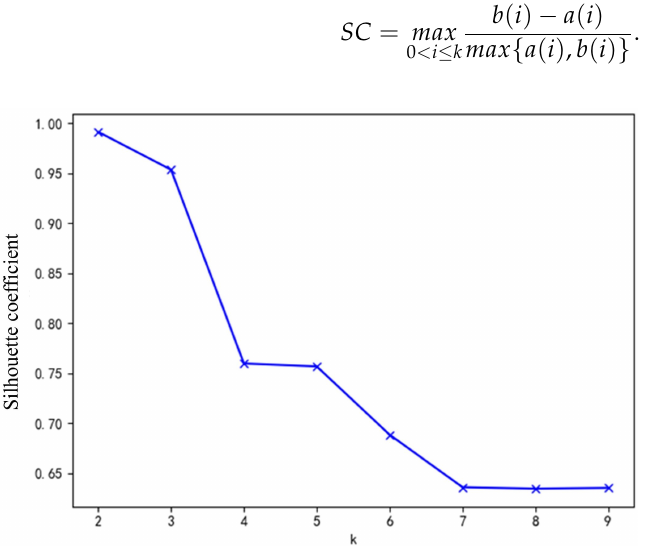
Figure 7. Silhouette coefficient with different values of k